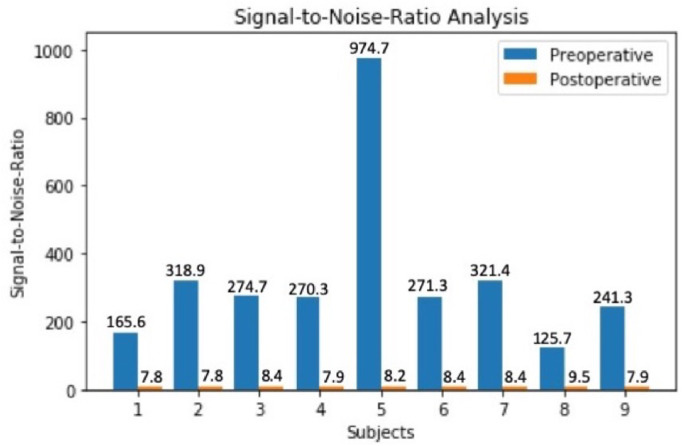
Results of the pre and post-operative signal-to-noise analysis across subjects, subject 5 scanned pre-operatively at 1.5 T.